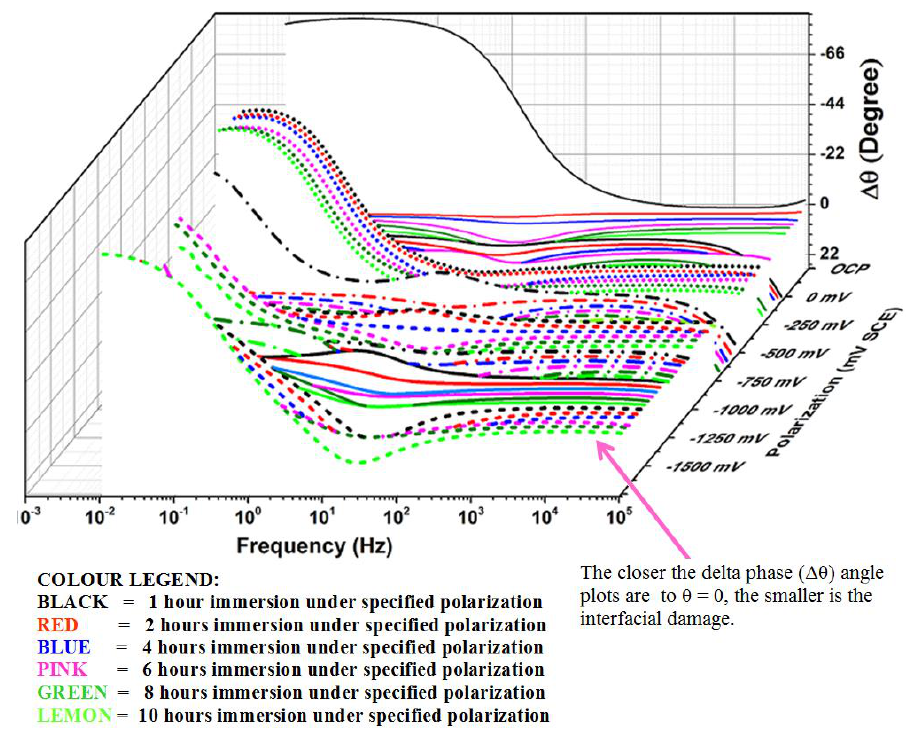
Figure 6. Delta Phase angle plots for CFRP in 50 mM NaCl at different times and cathodic polarizations made with respect to the phase angle after 1 h immersion at open circuit potential (OCP) (first plot in black solid line) to monitor interfacial degradation of the carbon fiber and epoxy interface (after Taylor Refs. [343] and [355]).